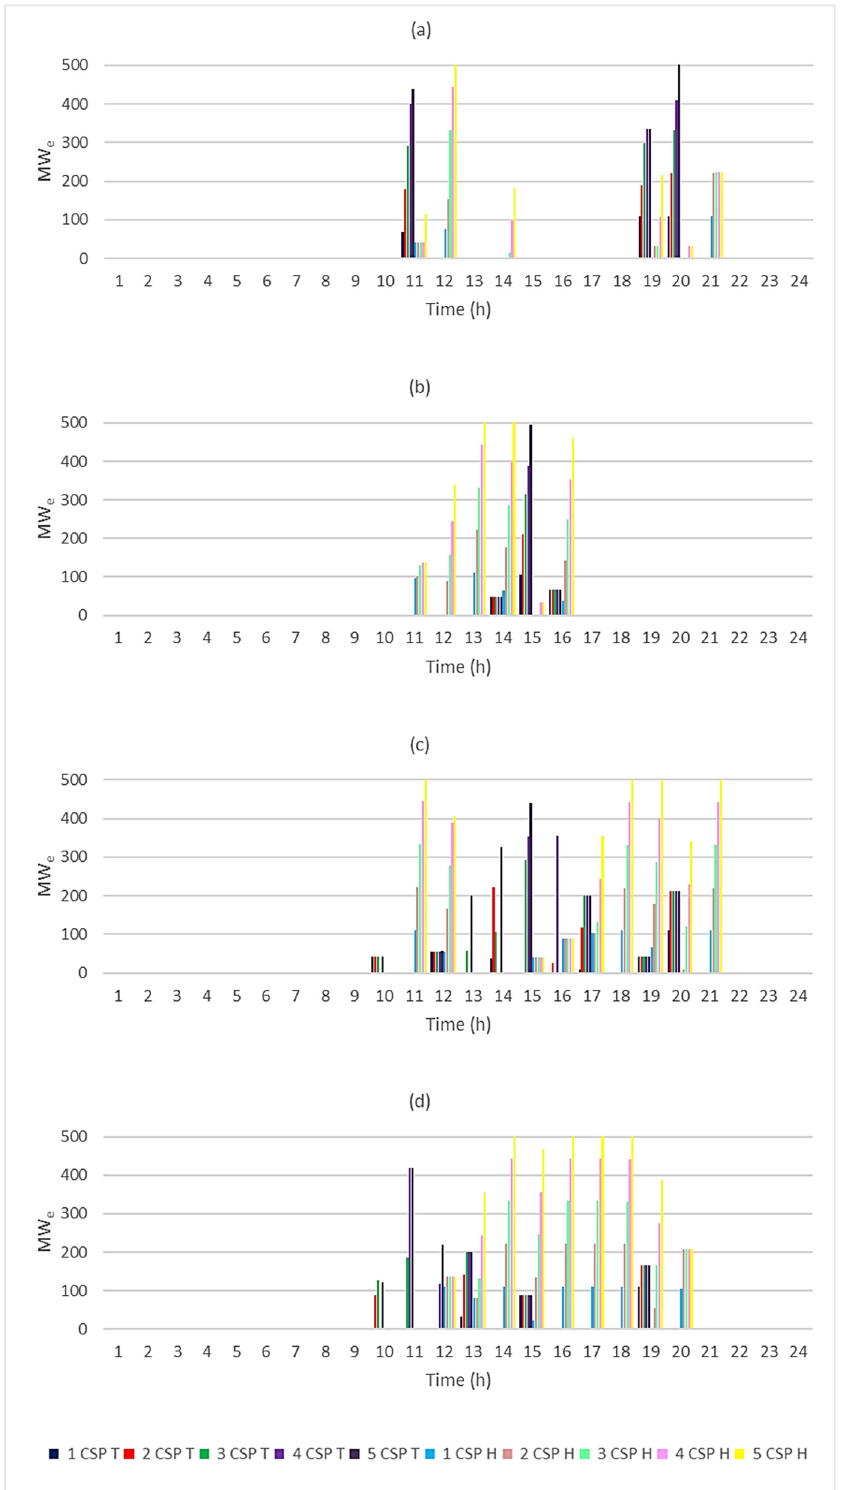
Figure 9. Reduction in thermal and hydroelectric generation in the following scenarios: